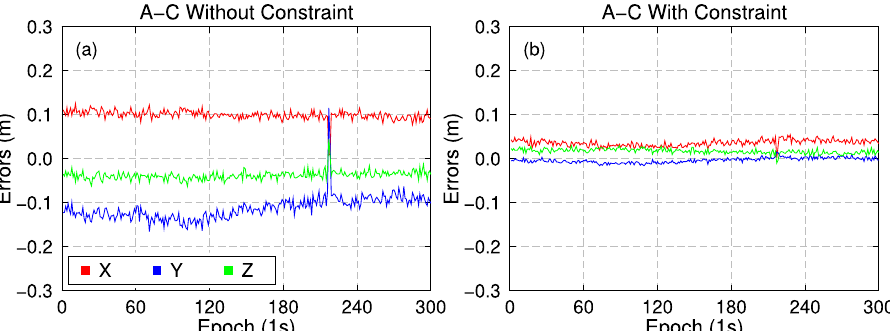
Figure 16. L1/B1 ambiguity float solutions of baseline A–C without ( a ) and with ( b ) static levelling constraint.